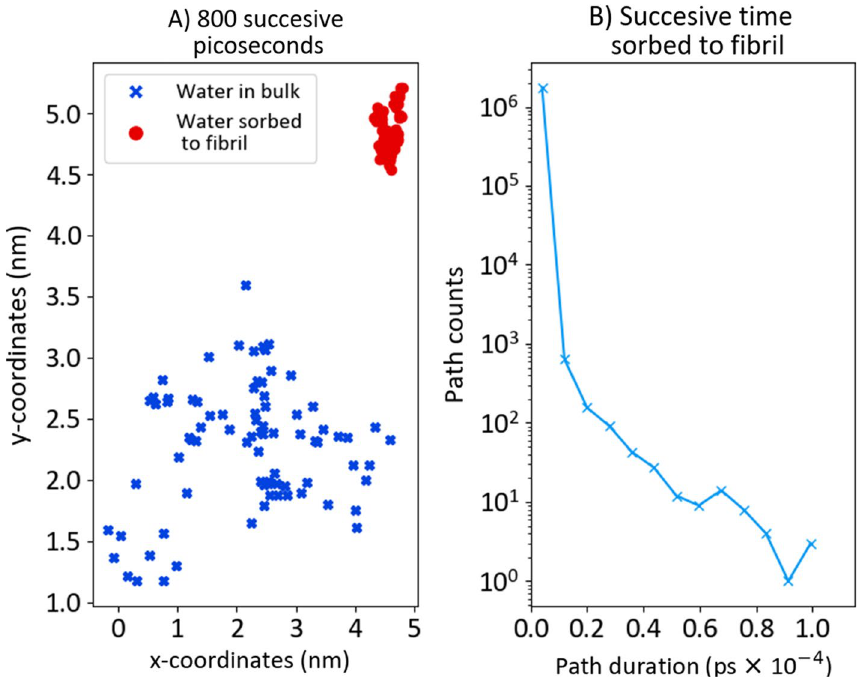
Figure 5. ( A ) Successive 800 ps (80 steps) diffusion in the bulk and sorbed to the fibril of the same water molecule. ( B ) Successive time a water molecule spends sorbed to a fibril. Simulations were performed at 25 °C.